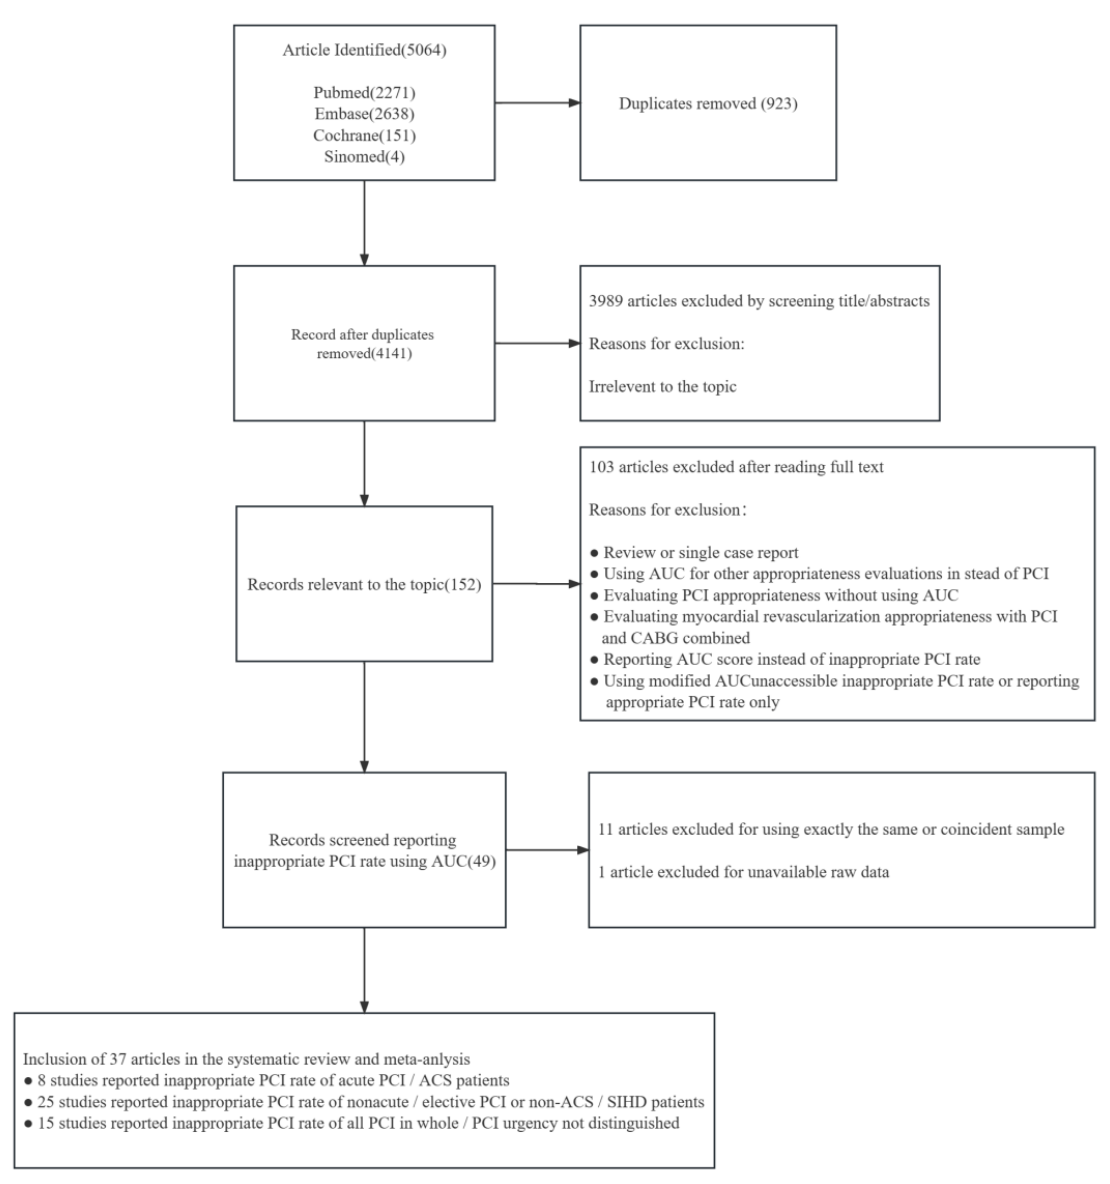
Figure 1. Flow chart of the meta-analysis exclusion/inclusion criteria for individual articles.